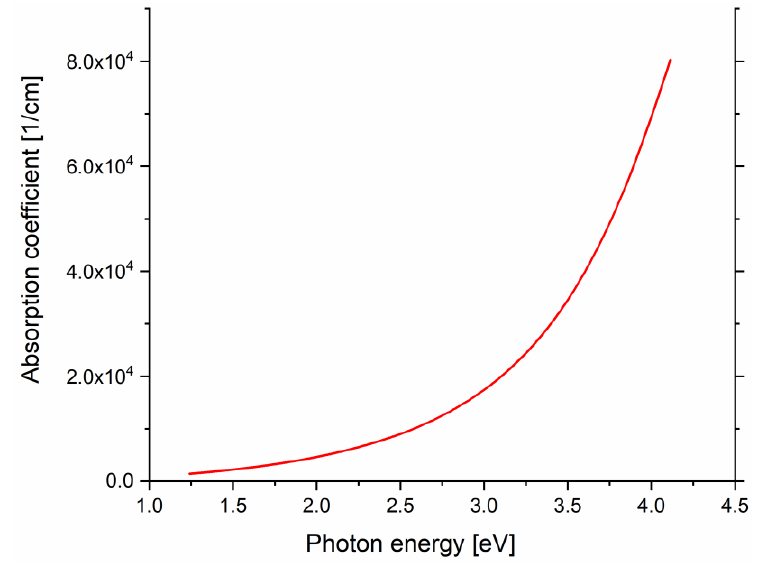
Figure 10. Absorption coefficient against photon energy for GO films.